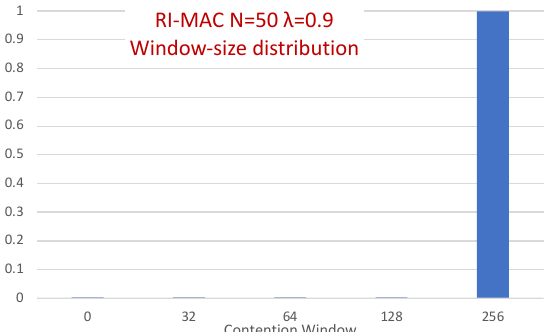
Figure 14. Hidden-terminal topology: RI-MAC contention window size distribution (PDF) for N = 50 and λ = 0.9.